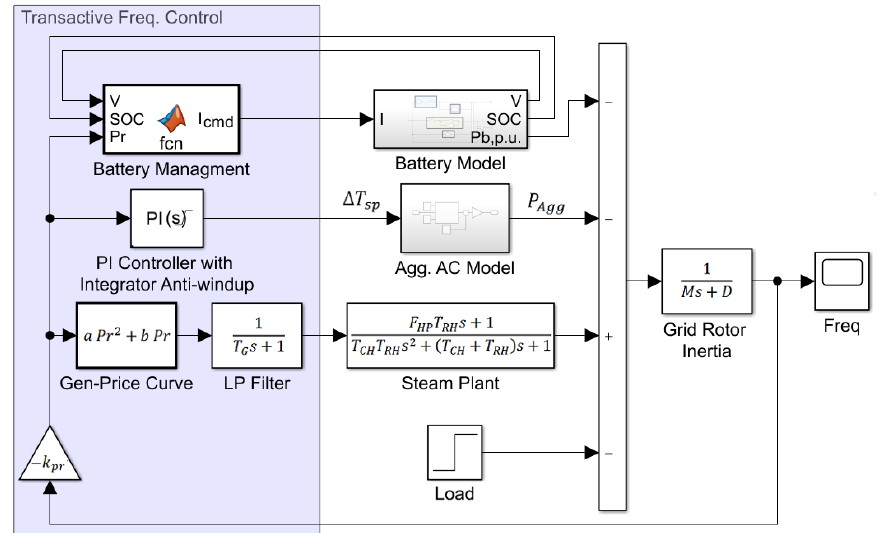
Figure 16. Integrated battery-AC-automatic generation control (AGC) transactive frequency control system.